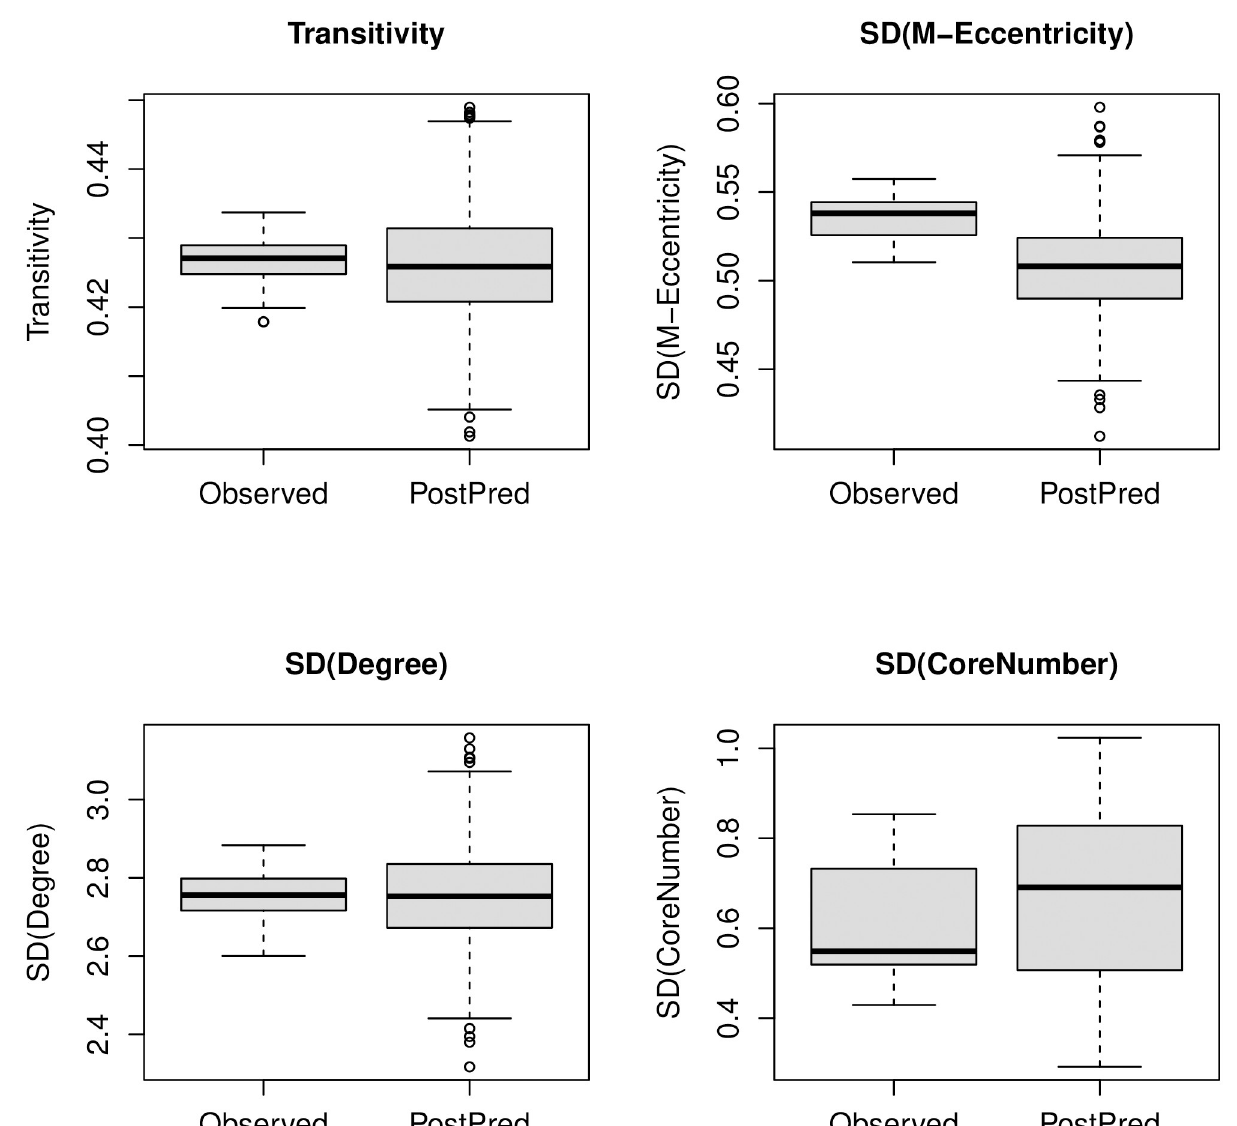
Fig 6. Variation in graph-level indices for lysozyme PSNs, observed versus posterior predictive distributions; simulated networks cover the observed GLI range, but also account for predictive uncertainty.